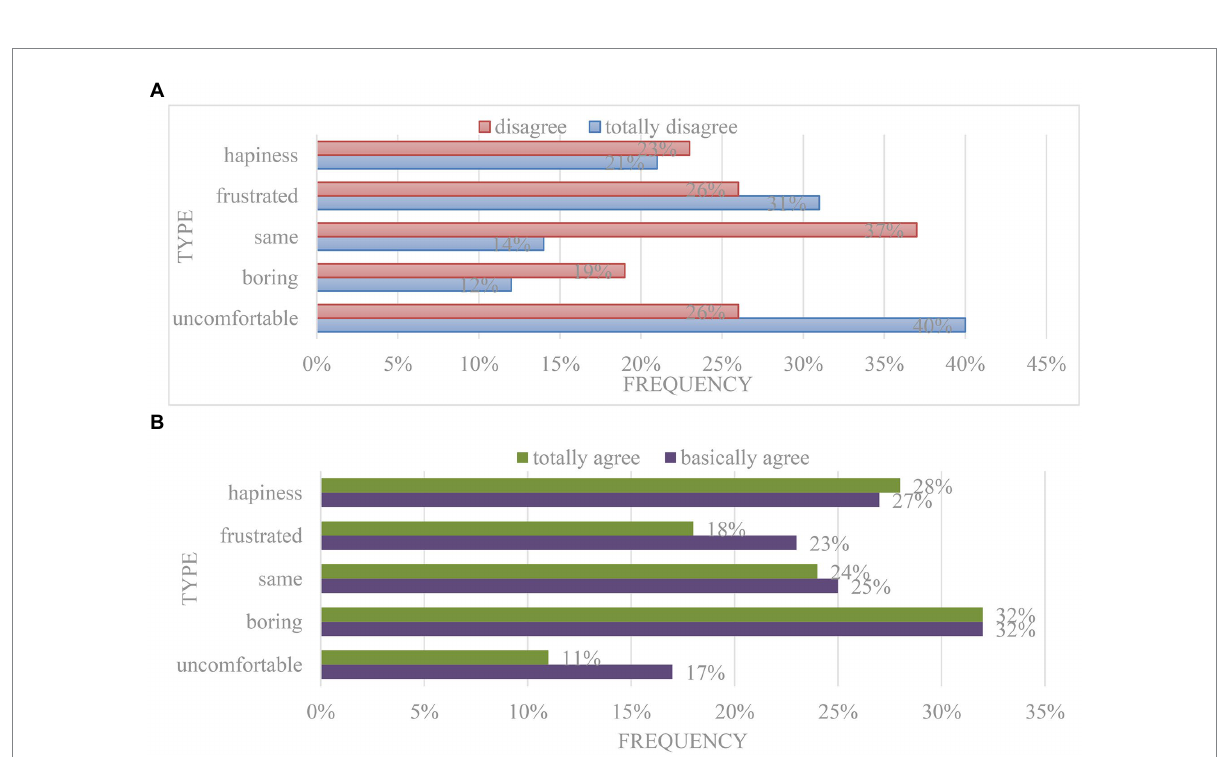
FIGURE 7 The influence of online education mode on college students’ mood. (A) Freshmen. (B) Senior